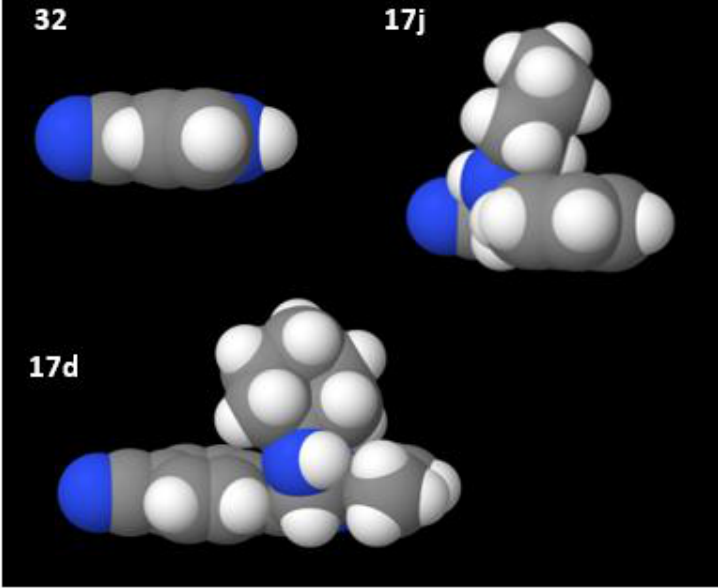
Figure 7. Space filling models of 7-azaindole-4-carbonitrile 32 , and Groebke – Blackburn – Bienaymé multicomponent reaction products 17j and 17d.